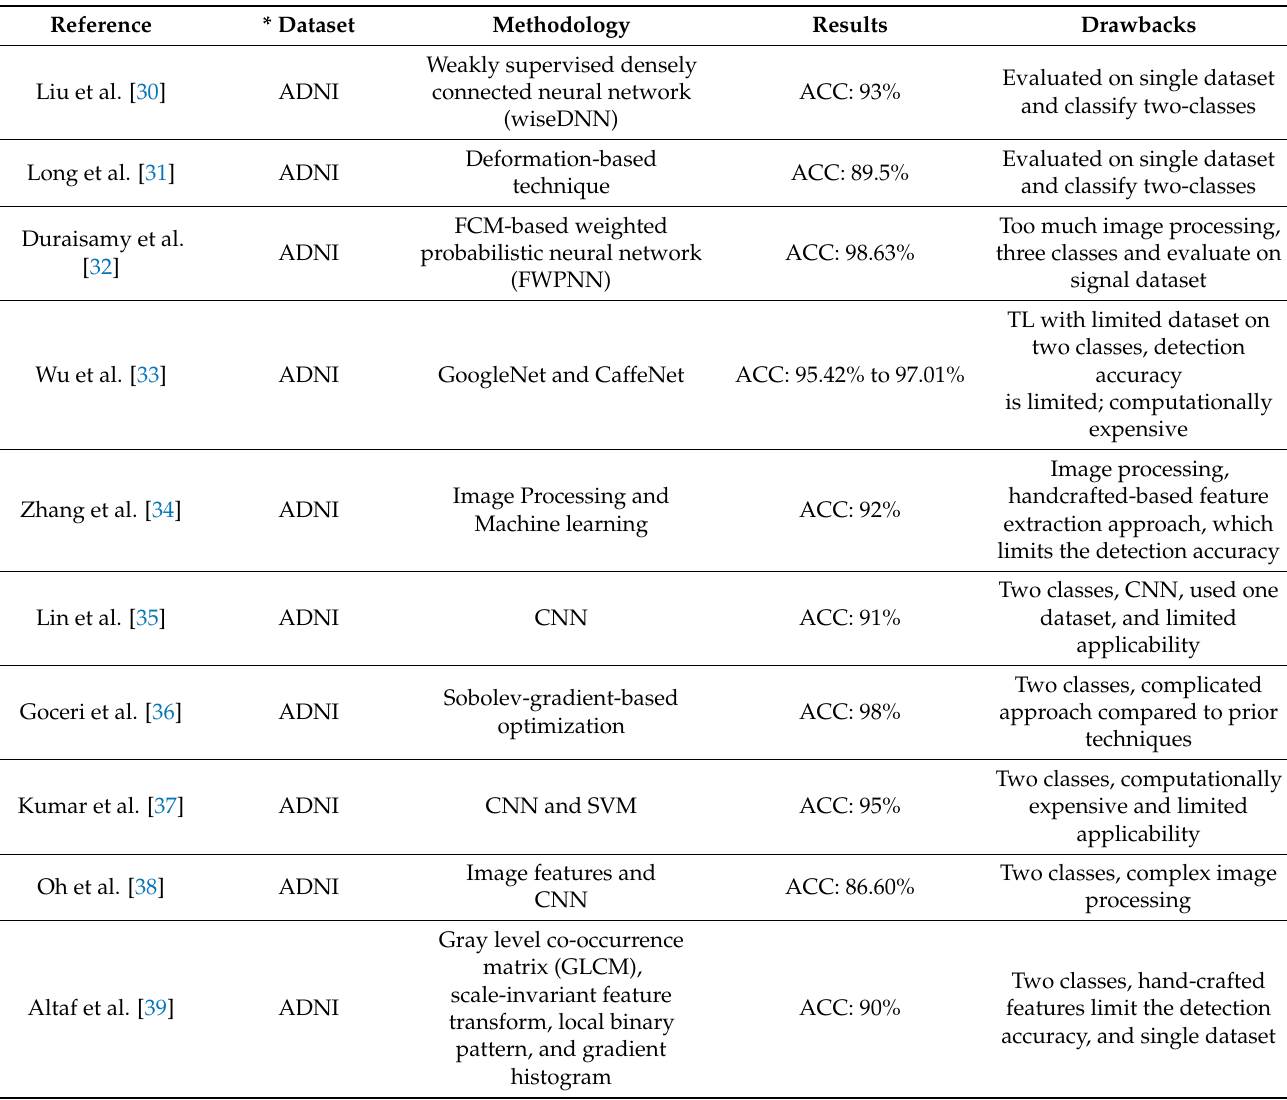
Table 1. A Comparative performance of existing work for the classification on ALZ